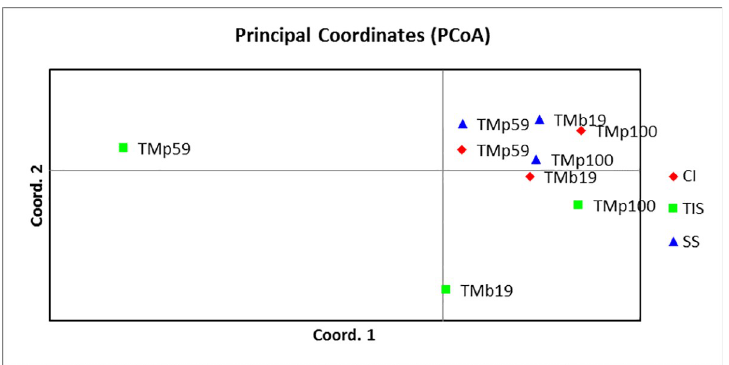
Fig 5. PCoA for Musa in vitro with Hpa II. CI: Complete Immersion, TIS: Temporary Immersion System, SS: Semi-